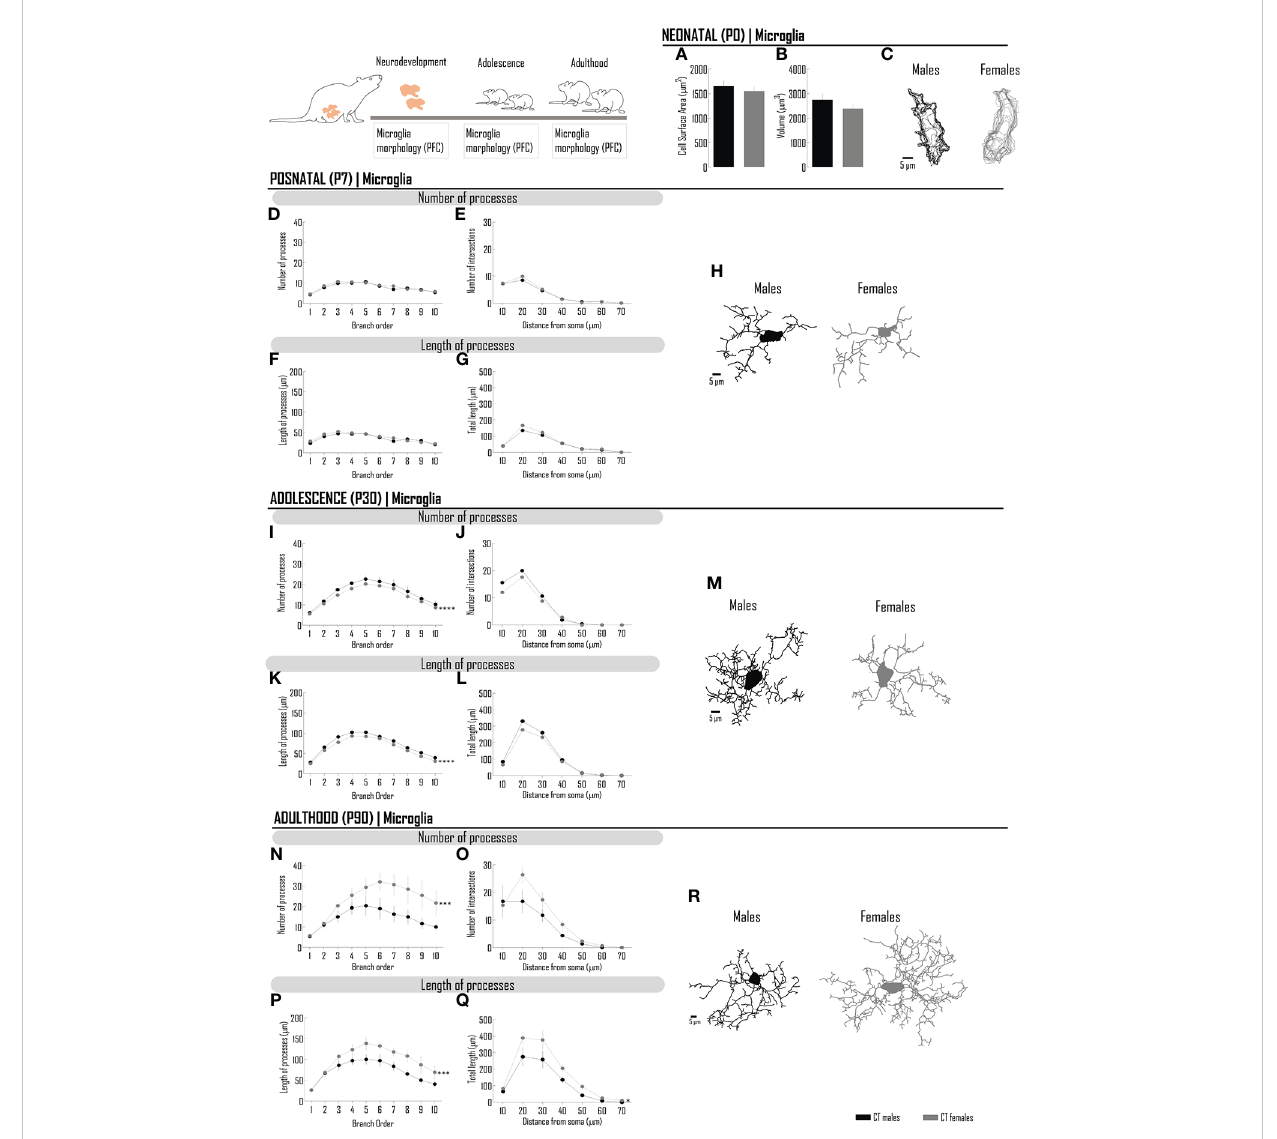
FIGURE 1 In the PFC, the morphological differentiation of microglia from birth to adulthood is dependent on the sex of the individuals. Microglia were stained with Iba-1 and 3D manual reconstructions were performed using Neurolucida Software. Different morphometric parameters were extracted at PND0 (A – C) , PND7 (D – H) , PND30 (I – M) and PND90 (N – R) : at PND 0, (A) cell surface area and (B) cell volume; at PND 7, 30 and 90, number and length of microglial processes per branch order (D, F, I, K, N, P) and sholl analysis (E, G, J, L, O, Q) of processes. Representative microglia projections from each life period are depicted in (C, H, M, R) . Results are presented as mean ± SEM. * p <0.05 comparing CT males (black circles) and females (gray